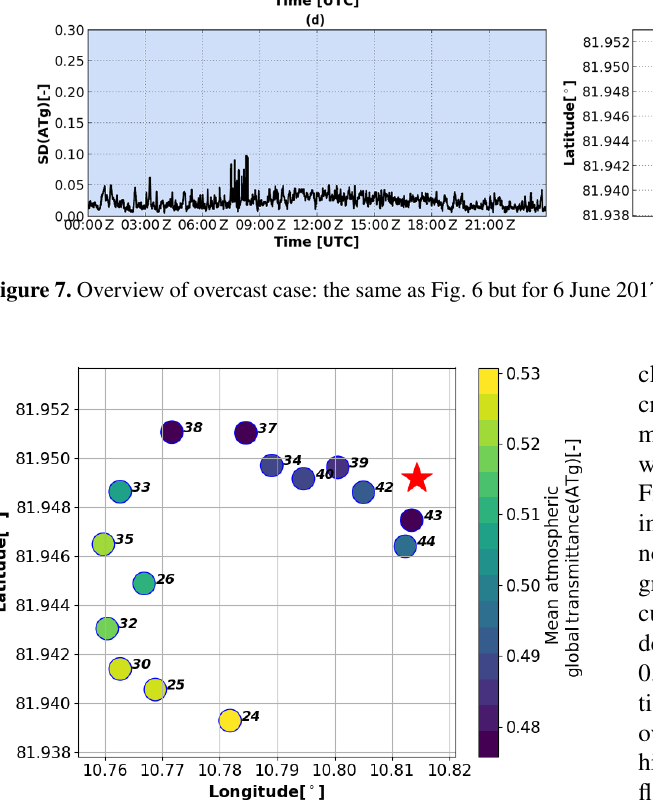
Figure 8. Station map showing the average atmospheric global transmittance for the overcast case (6 June 2017, 00:00–23:59Z). The red star marks the position of Polarstern